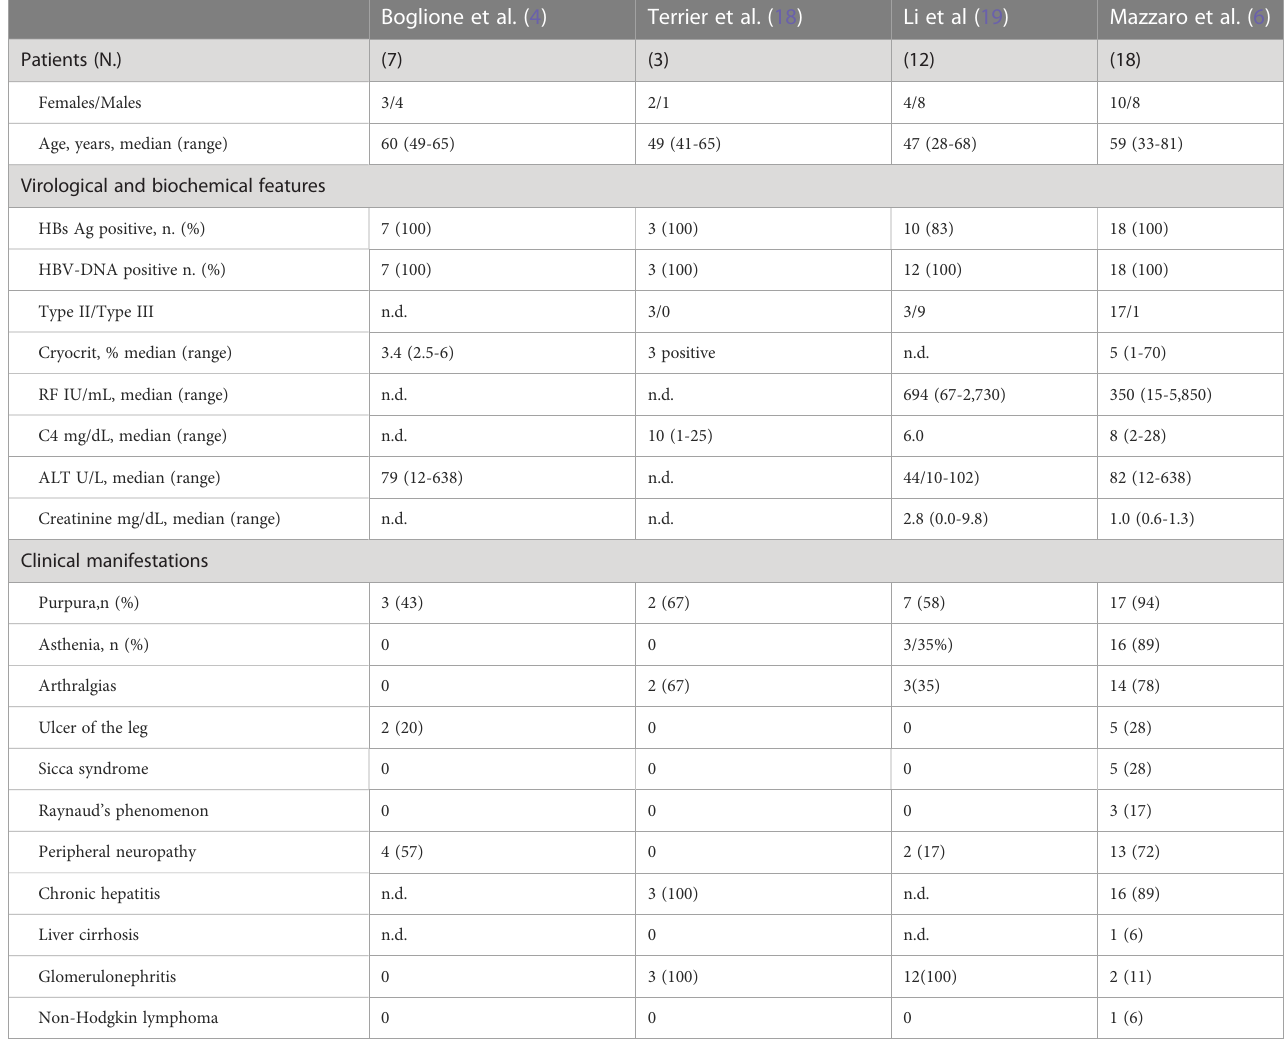
TABLE 1 Mains studies on HBV-related cryoglobulinemic vasculitis.